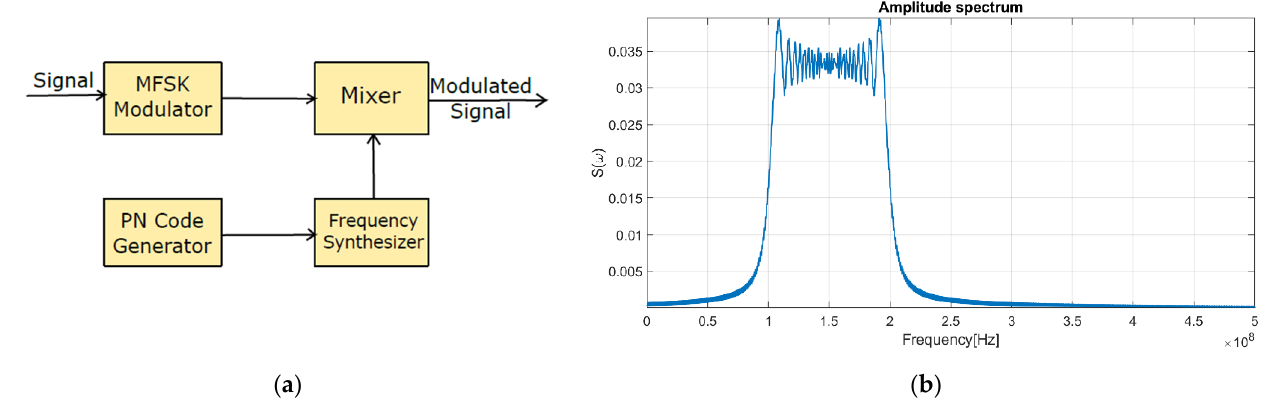
Figure 2. ( a ) Block diagram for FHSS implementation; ( b ) CSS signal spectrum.